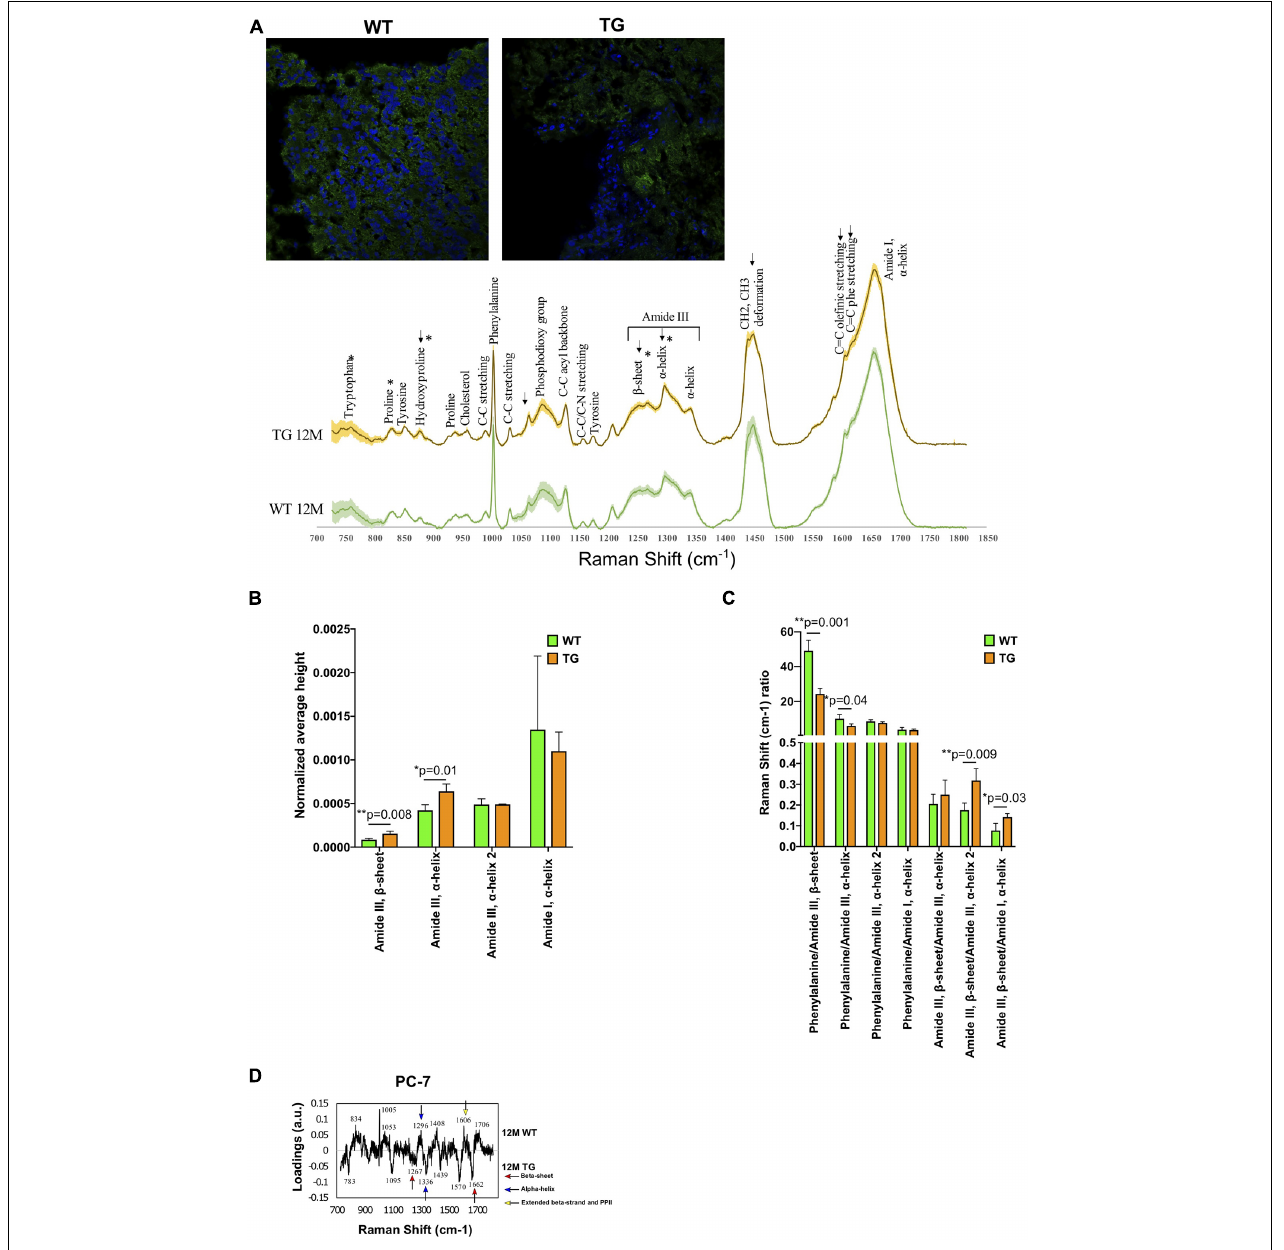
FIGURE 1 | Spectral comparison in 12M WT and TG olfactory bulb regions. (A) Immunofluorescence images show the staining of α -Syn in the WT and TG olfactory bulb region of the brain (upper panel) and the spectra of WT and TG olfactory bulb regions (lower panel) and shaded areas indicate standard deviation. (B) All the marked changes were from the statistical 12M WT and TG intensity comparison based on Student’s unpaired t -test. Differences were detected in the tryptophan ( p = 0.04), proline ( p = 0.02), hydroxyproline ( p = 0.04), amide III, β -sheet ( p = 0.008), and amide III, α -helix ( p = 0.01) peaks. p -Value represents *( p ≤ 0.05), **( p ≤ 0.01). (C) The ratio of different peaks from amide I and amide III were compared with Student’s unpaired t -test to identify statistical changes. Differences were detected in the phenylalanine/amide III– β -sheet ( p = 0.001), phenylalanine/amide III– α -helix ( p = 0.04), amide III– β -sheet/amide III– α -helix ( p = 0.009), and amide III– β -sheet/amide I– α -helix ( p = 0.03). p -Value represents * p ≤ 0.05 and ** p ≤ 0.01. (D) The 12M WT and TG samples were compared with PCA of PC-6 and PC-7. The loadings of PC-7 were visualized. Positive side WT while negative side TG brain samples.